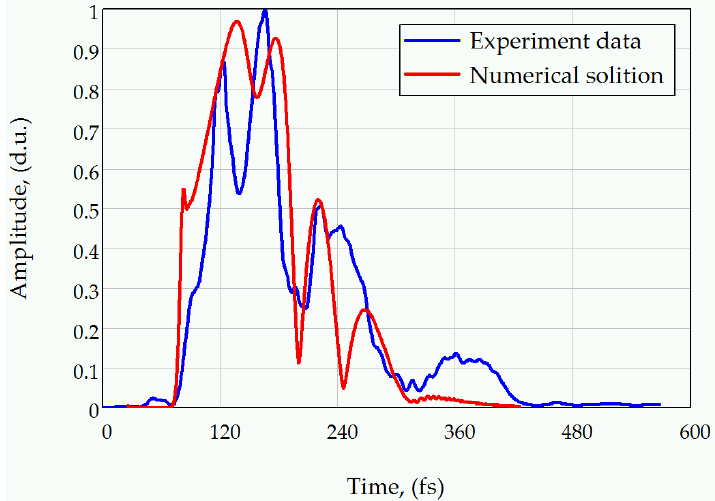
Figure 1. The pulse form evolution in fiber. Numerical calculation results of coupled nonlinear Schrödinger equations system are marked by the red line and the experimental results obtained by [9–16] are marked by the blue line.